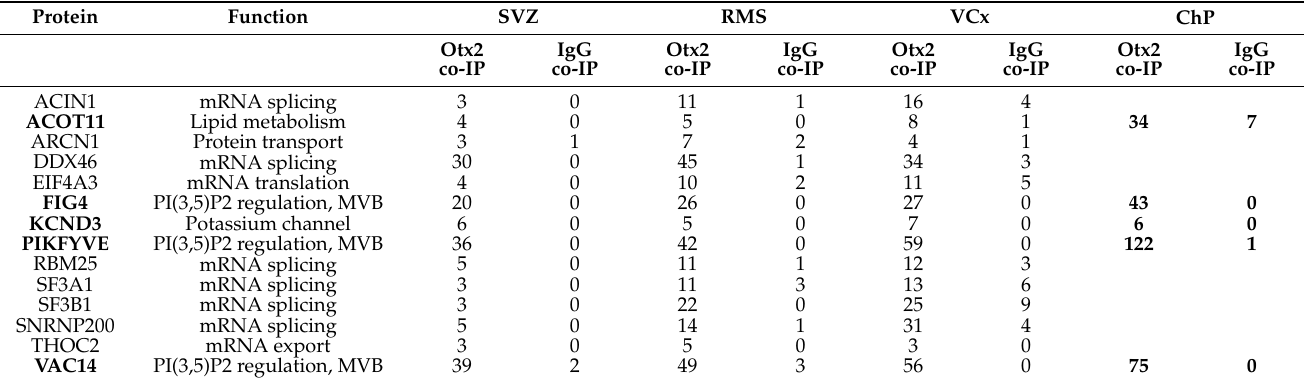
Table 7. Peptide number comparisons of OTX2 putative protein partners common to non-cell-autonomous structures. Cell-autonomous partners are indicated in